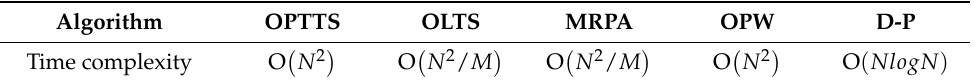
Table 5. Time complexity of five